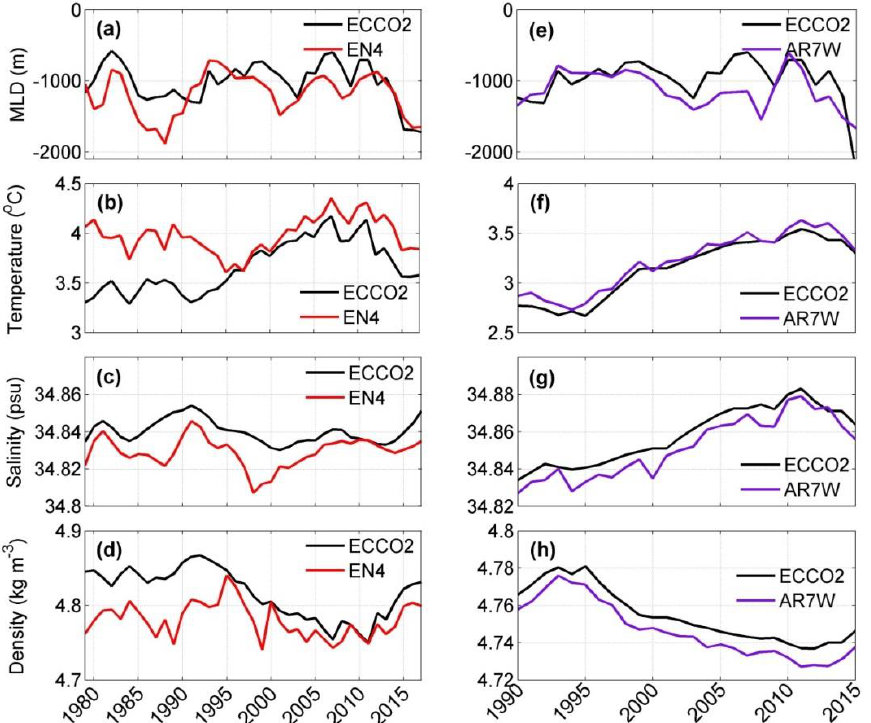
Figure 2. (Left column) Time series of EN4 (red lines) and ECCO2 (black lines) ( a ) MLD, ( b ) temperature, ( c ) salinity, and ( d ) density averaged over the central Labrador Sea region (within the 2000−m isobath) at the LSW depth between 200 and 2000 m. Values in ( d ) and ( h ) minus 23. (Right column, ( e – h) ) As in the left column, but for the data collected along the AR7W section. Note that the modeled LSW is slightly denser than observed induced by the slightly higher modeled salinity. The LSW is defined as Stramma et al., (2004) [52] that is bound by the isopycnals σΘ = [27.68, 27.80] kg m −3 .